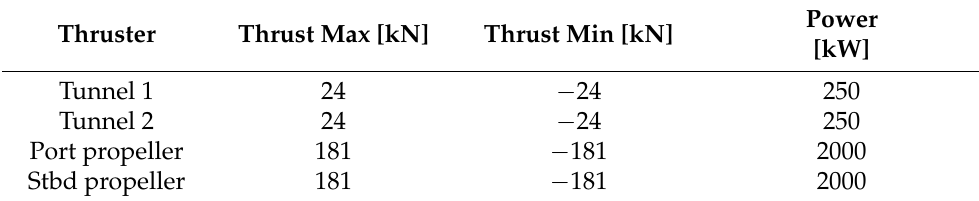
Figure 13. The result of the capability plot analysis. Apart from the thrusters listed in Table 7, the ship is equipped with a set of four anchors: two in the bow and two in the stern. Table 7. Thrusters data for a ship with an anchor set.